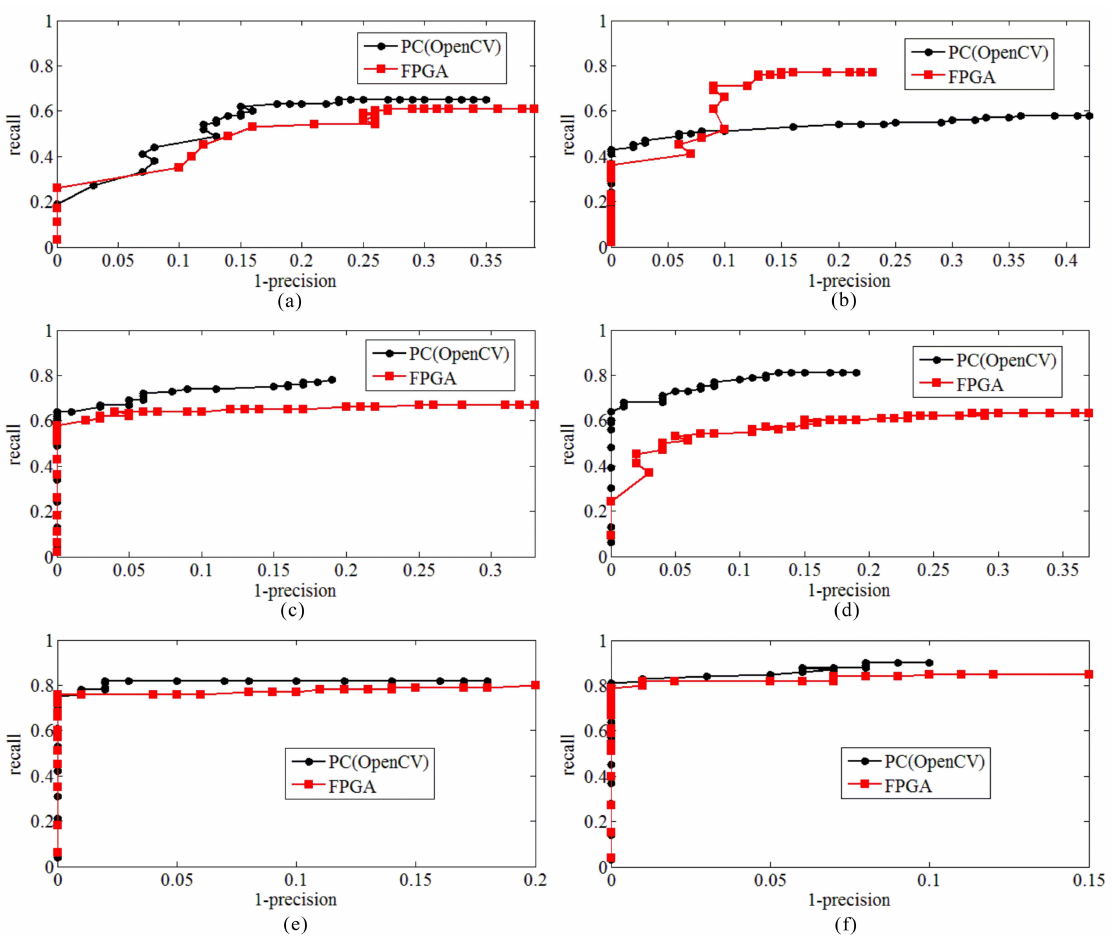
Figure 12. 1-precision versus recall of six image pairs, ( a ) bare soil; ( b ) trees; ( c ) expressways; ( d ) rural roads; ( e ) bungalows; ( f ) high-rise